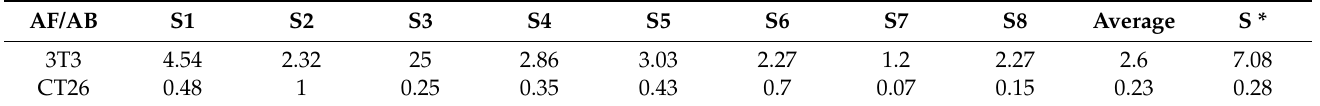
Table 2. The ratios of areas under calculated Gauss curves of free and bound NADH, AF/AB at pH 7